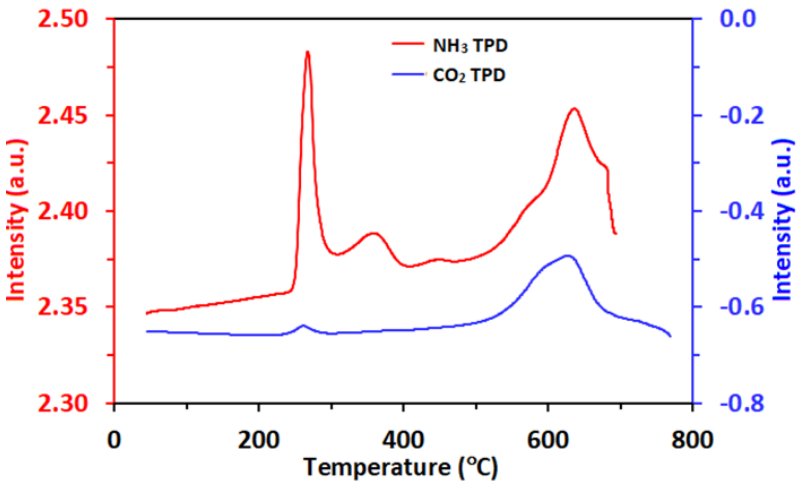
Figure 2 . NH 3 -TPD and CO 2 -TPD profiles of the synthesized ZIF-L . Figure 2. NH 3 -TPD and CO 2 -TPD profiles of the synthesized